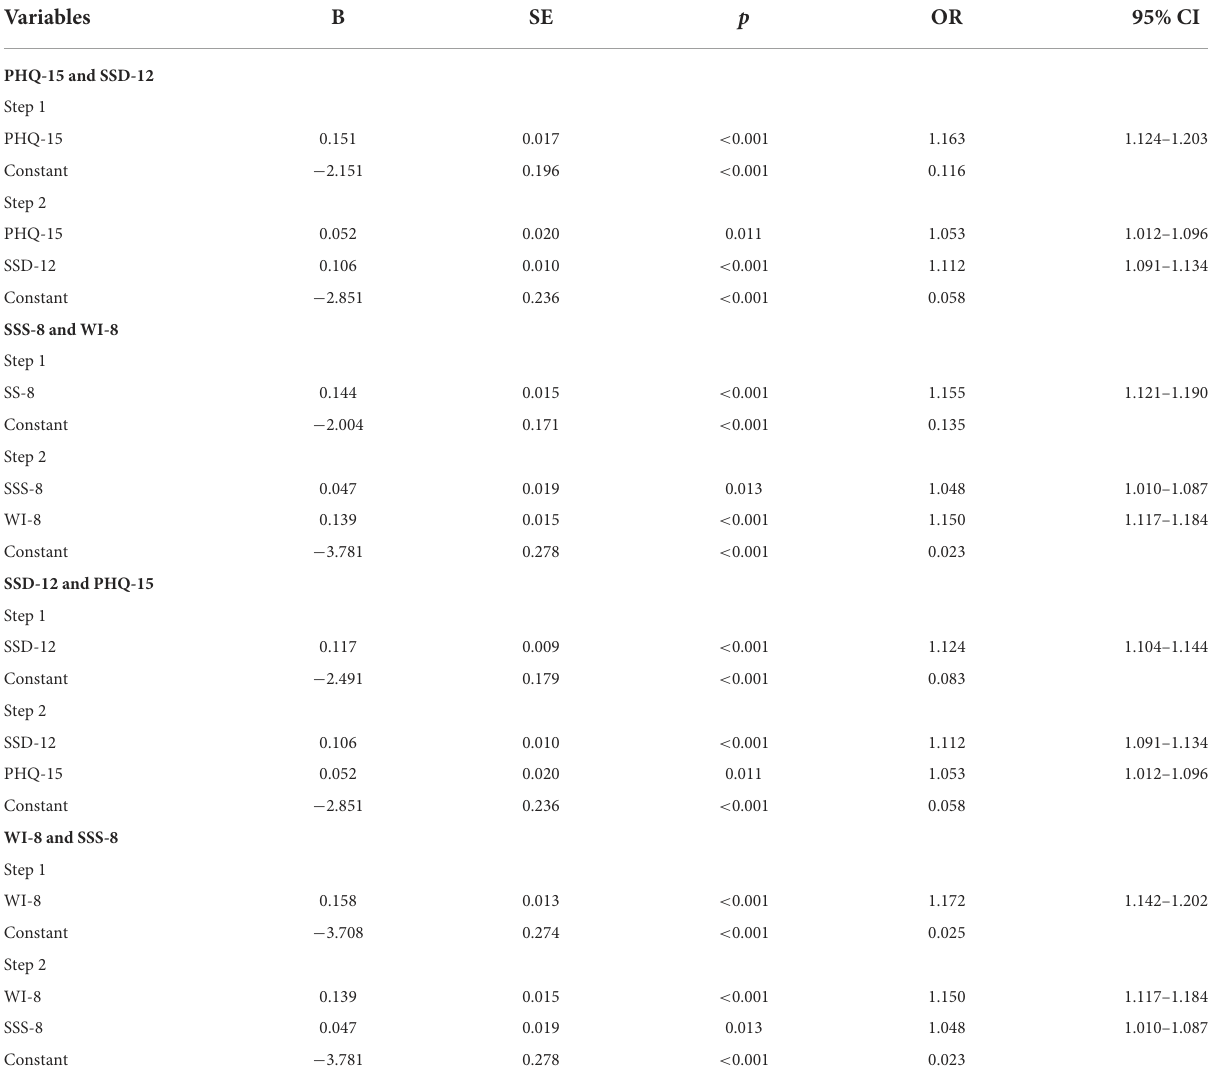
TABLE 2 Stepwise logistic regression analysis evaluating the PHQ-15/SSS-8 and SSD-12/WI-8 as predictors for SSD diagnosis ( n = 694).